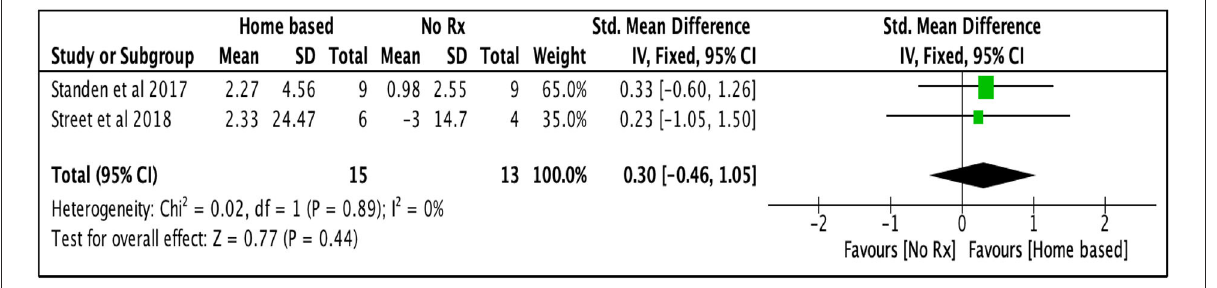
FIGURE6 Comparison of the effect of home-based intervention and no treatment on UL function after the